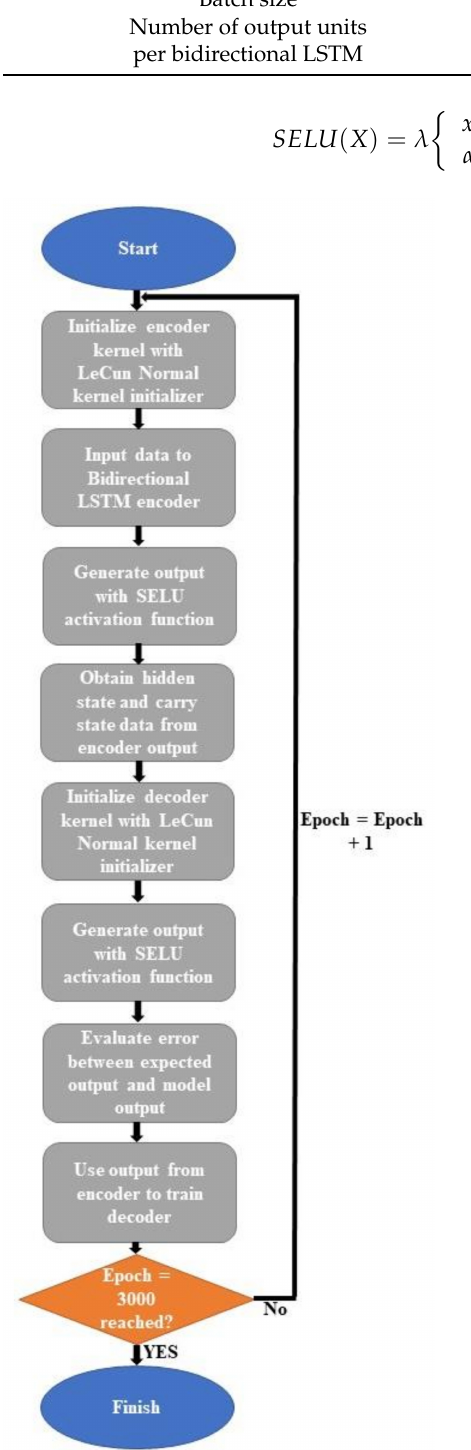
Figure 8. The overall training procedure for Seq2Seq